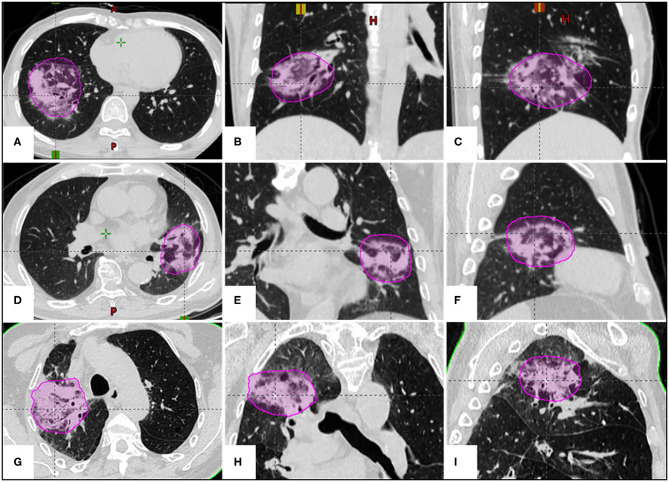
The examples of correlation between lung BED70 (magenta circle) and SRP in three different SBRT fractionations. (A–C) A 39-year-old female patient with adenocarcinoma in the right lower lobe received a prescription dose of 50 Gy in 5 fractions (VBED70 = 4.88%); (D–F) a 76-year-old male patient with metastatic lung tumor in the left upper lobe received a prescription dose of 60 Gy in 8 fractions (VBED70 = 3.78%); (G–I) an 85-year-old male patient with squamous cell carcinoma in the right upper lobe received a prescription dose of 60 Gy in 10 fractions (VBED70 = 3.15%).